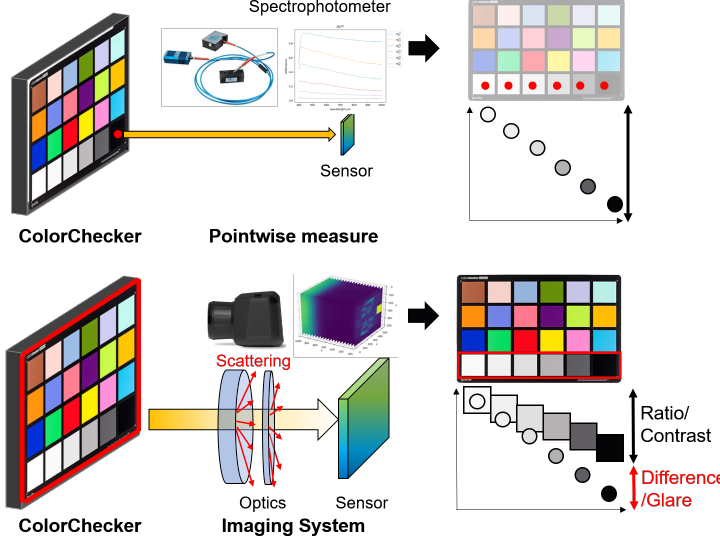
Figure 1. Glare effect. On the top, a graphical representation of a pointwise measure of reflectance. In this system, the reflectance spectrum is acquired directly from a portion of the surface in standard colorimetric conditions (illumination geometry, direction of observation, and light source). On the bottom, a graphical representation of an imaging system, where the scene information is acquired through a sensing pipeline which requires optics. Thus, the scattering phenomena can induce the glare effect and decrease the contrast of the final image. In this work, to provide a measure of the glare effect, we performed a comparison between the ratio of the grayscale patches acquired through a pointwise system and the ratio of the grayscale patches acquired through a hyperspectral image (HSI)